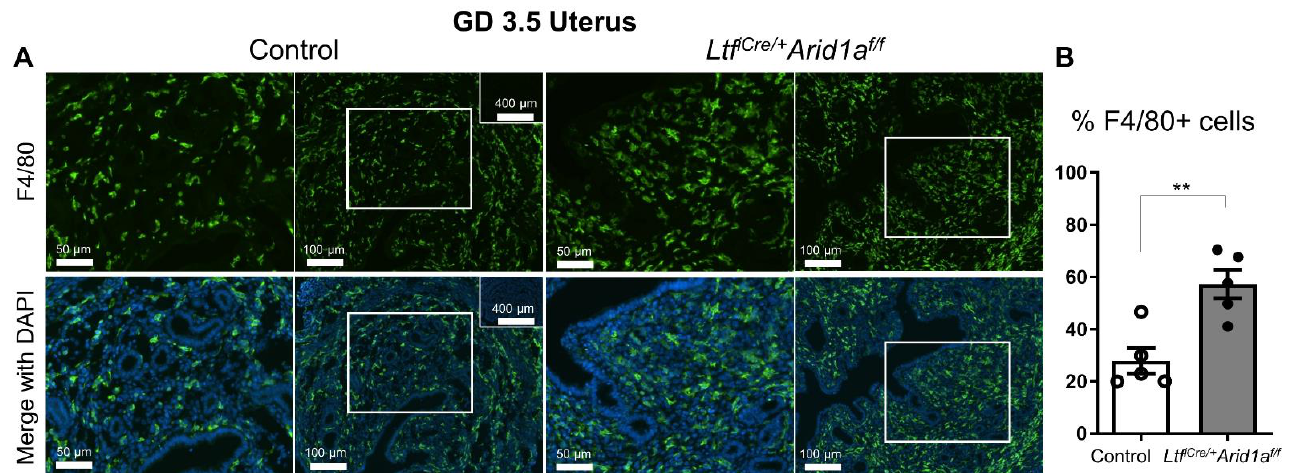
Figure 5. Uterine F4/80+ macrophage numbers are elevated in Ltf iCre/+ Arid1a f/f mice at GD 3.5. ( A ) Representative images of F4/80 immunofluorescence (green) counterstained with DAPI (blue) in control (left) and Ltf iCre/+ Arid1a f/f (right) mouse uterine sections at GD 3.5 ( n = 5/genotype). For each group, the left image is higher magnification (scale bar = 50 µm) and the right image is a lower magnification region containing the zoomed region (indicated by large white rectangle; scale bar = 100 µm). The small insets in the upper right corner of the control images show no primary antibody negative controls (scale bar = 400 µm). ( B ) The percentage of F4/80-positive uterine cells was counted in representative stromal fields of approximately 350 cells per sample of control ( n = 5, empty bar) and Ltf iCre/+ Arid1a f/f ( n = 5, grey bar) uteri at GD3.5. The graph represents the mean ± SEM. **, p < 0.01.